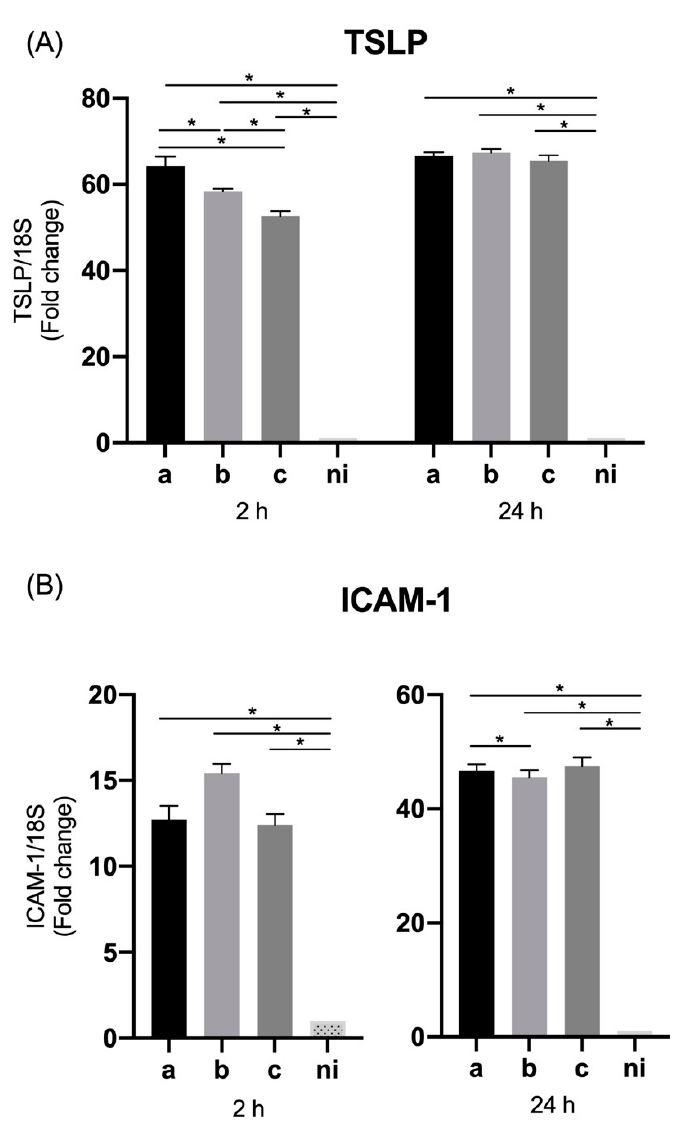
Figure 8. TSLP and ICAM-1 mRNA expression by A. actinomycetemcomitans -induced THP-1 human macrophages (ATCC ® TIB-202™). Expression in macrophages infected at a MOI = 10 2 with strains ATCC ® 43717 TM (serotype a), ATCC ® 43718 TM (serotype b), and ATCC ® 43719 TM (serotype c), 2 and 24 h after infection. For relative expression, mRNA expression in non-infected (ni) macrophages was considered as 1, as a reference for fold-change in expression using 18S rRNA expression levels as a normalizing endogenous control. Data are represented as fold-change means and standard deviation of three independent experiments performed in duplicate. ( A ) TSLP, ( B ) ICAM-1. Asterisks were used to indicate a value of p considered statistically significant (* p < 0.05).